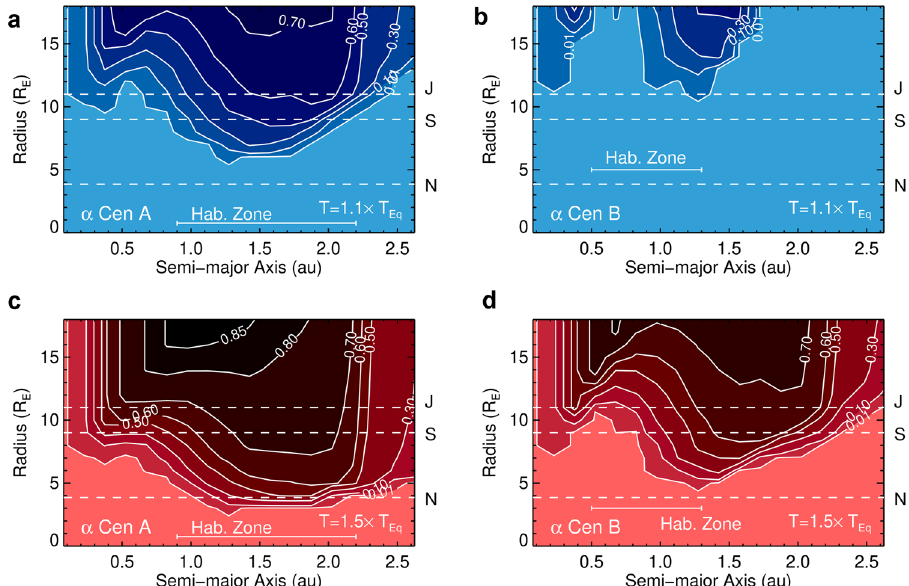
Fig. 5 Completeness to planets of various radii and orbital semi-major axes. ( a ) and ( b ) assume A B = 0.3 and internal heating contributing 10% of the equilibrium temperature, whereas ( c ) and ( d ) assume A B = 0.3 and internal heating contributing 50% of the equilibrium temperature. Radius and semi- major axis were uniformly sampled along with an inclination prior of P( i ) ∝ sin i (see supplementary methods, completeness analysis). The dashed lines correspond to the radii of Neptune, Saturn, and Jupiter (N, S, and J, respectively). Contour units are